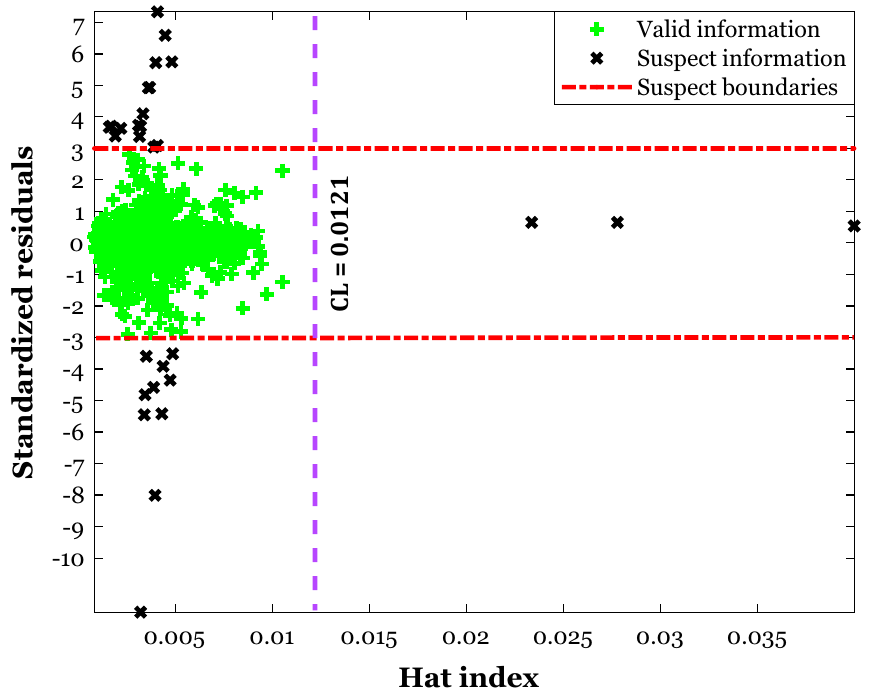
Figure 6. The results of applying the leverage method on the gathered density databank.